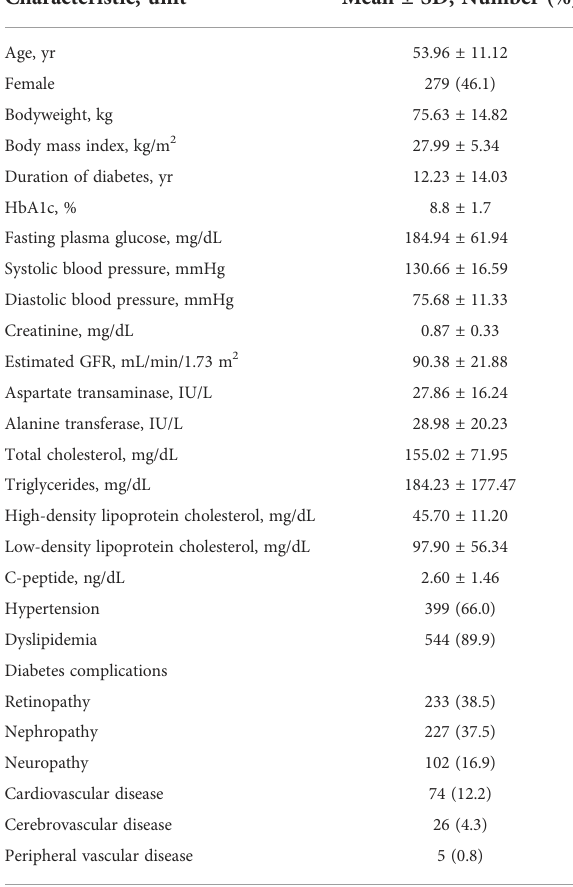
TABLE 2 Baseline characteristics of the study population.